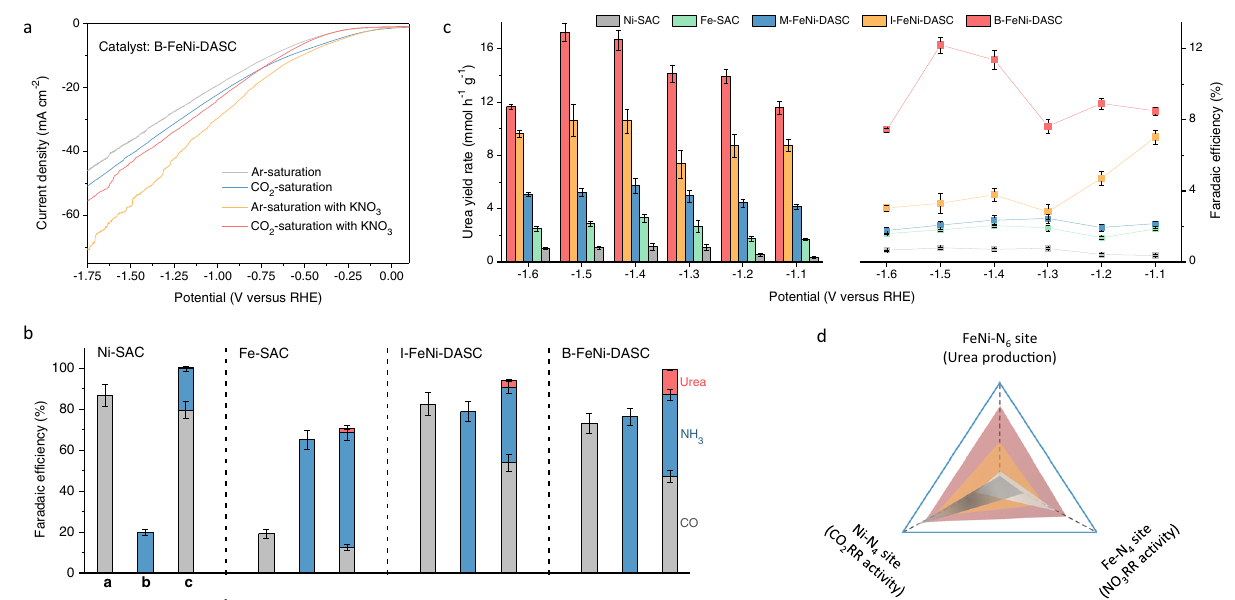
Fig. 2 | Electrocatalytic performances for urea synthesis. a LSV curves over B- FeNi-DASC. b TheproductdistributionsofCO 2 RR,NO 3 RRandureasynthesisonNi- SAC,Fe-SAC,I-FeNi-DASC,andB-FeNi-DASCat − 1.4VversusRHE. c Ureayieldrates and corresponding Faradaic ef fi ciencies on Ni-SAC, Fe-SAC, M-FeNi-DASC, I-FeNi-